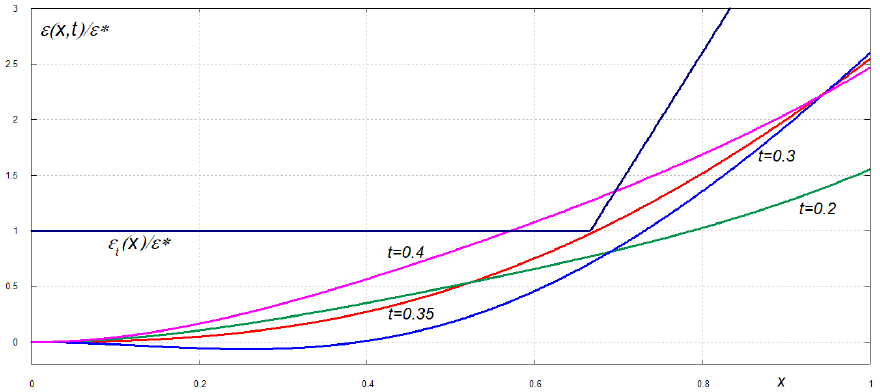
Figure 10. Scaled strain distributions near the time instant, when the plate breaks second